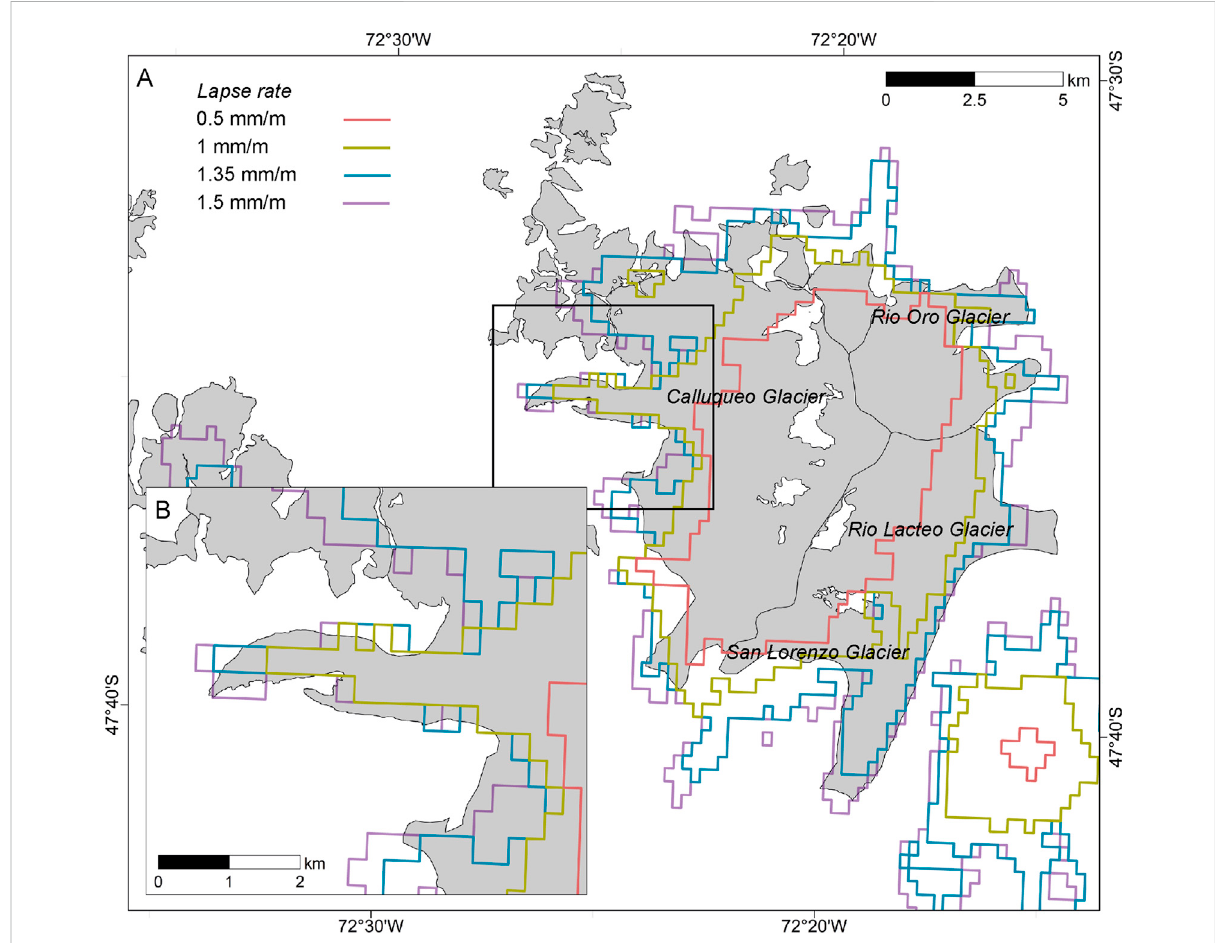
FIGURE 3 Experiment B. (A) Simulated ice extent produced by PISM forced using spatially variable precipitation datasets derived from different precipitation lapse rate values. The grey polygon indicates present day ice area from the RGI. (B) Inset map of an enlarged section of Glaciar